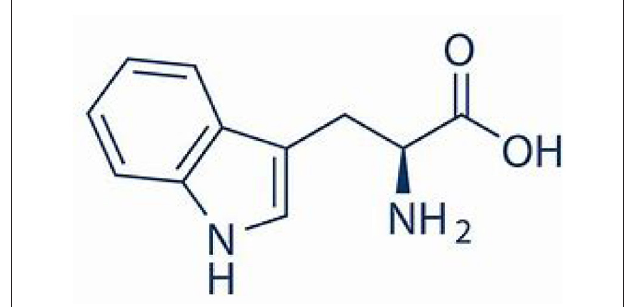
FIGURE 1 | Chemical structure of